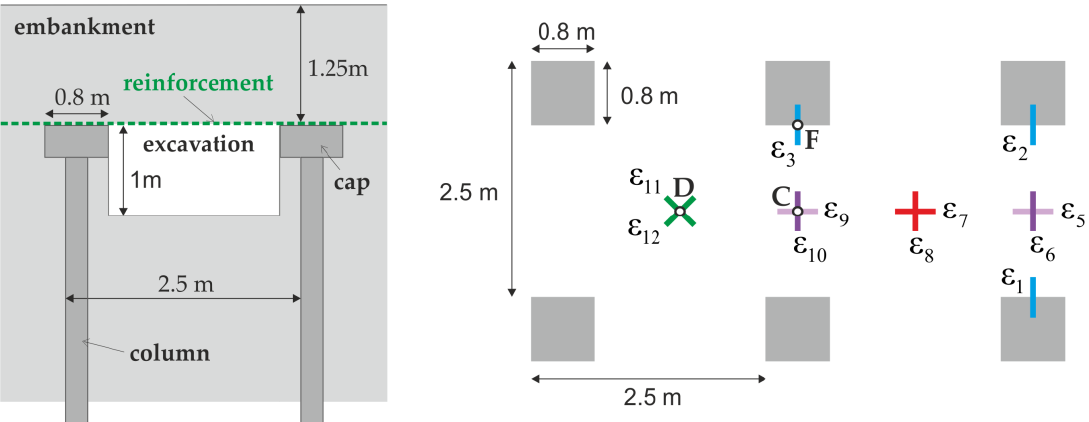
Figure 2. Full scale experimental setup according to [26,32,33]; C, D, F—points acc. Figure 3.